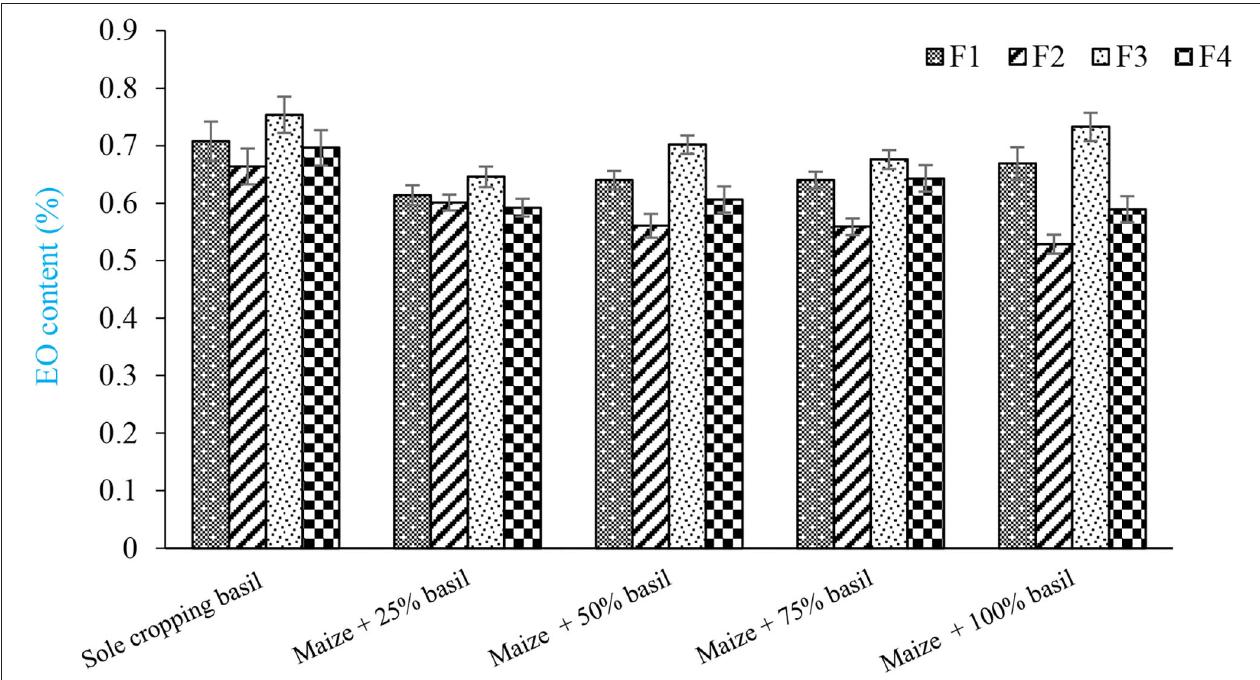
FIGURE 1 | Mean comparisons of interaction of cropping patterns and N 2 fixing bacteria on content of basil essential oil. F1, control; F2, 100% chemical fertilizer (N); F3, Azospirillum brasilense and Azotobacter chroococcum ; F4, integration of A. brasilense and A. chroococcum + 50% nitrogen chemical fertilizer.